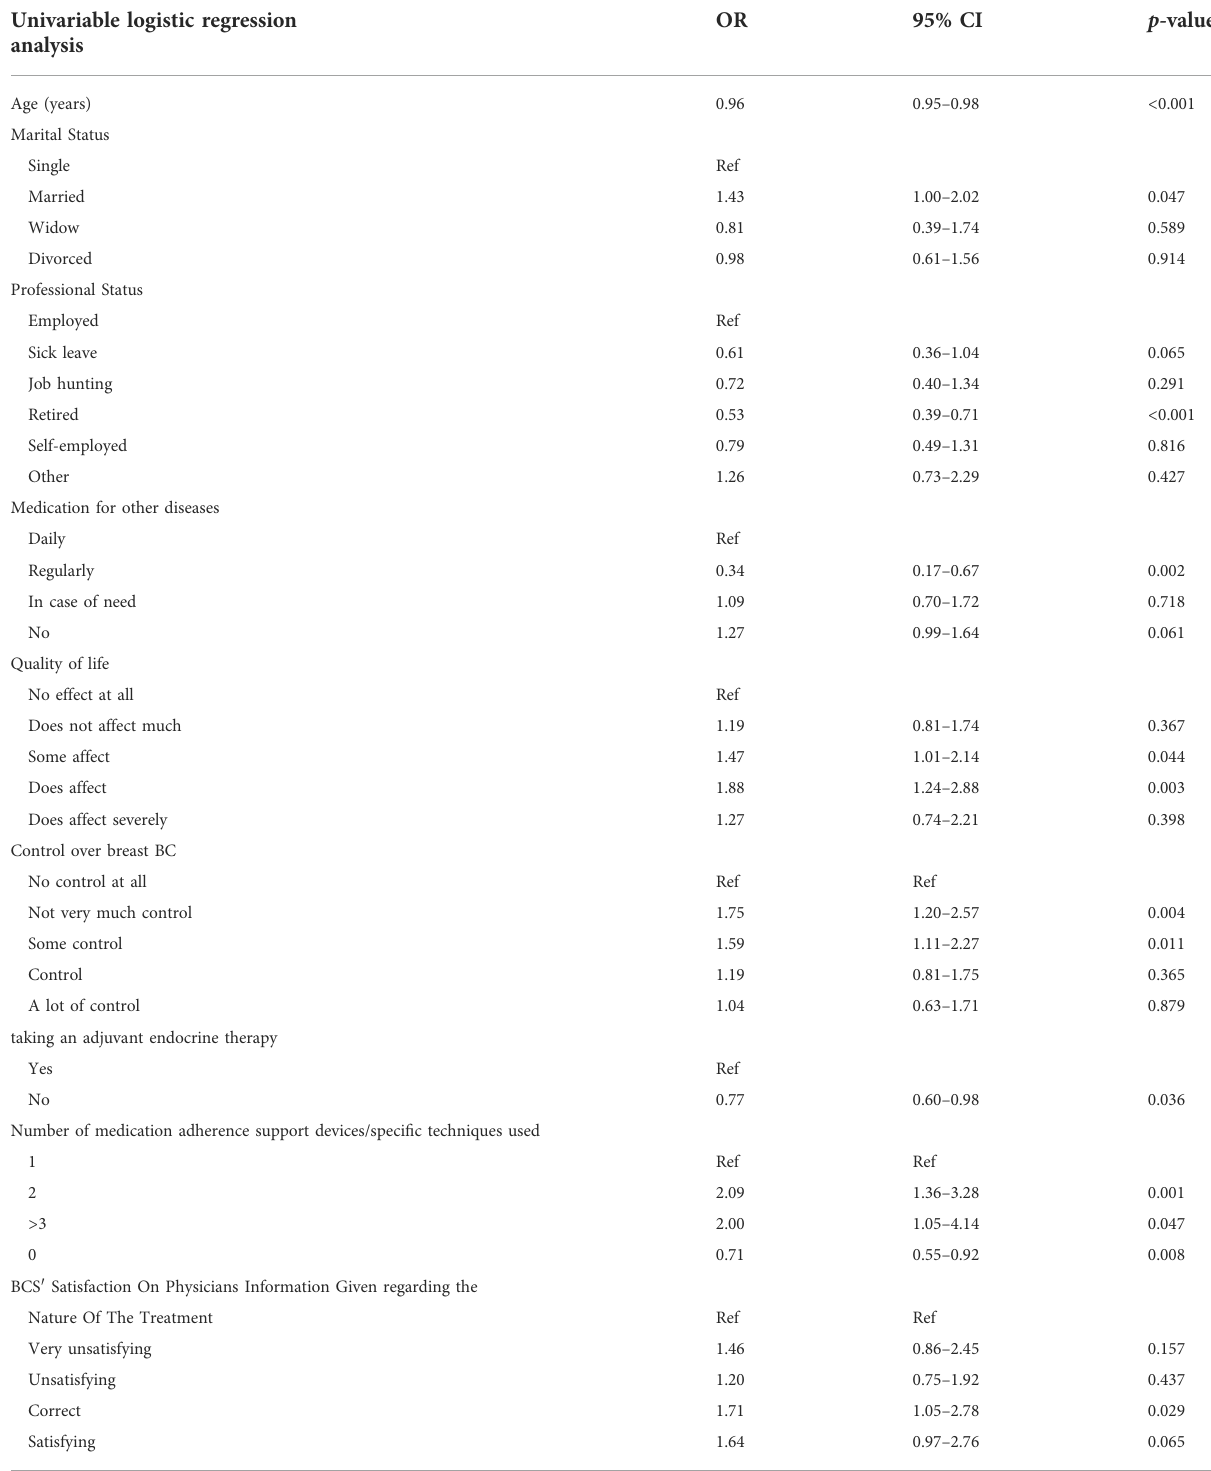
TABLE 3 Factors associated with accepting an eHealth tool to manage OHT in BCS (Seintinelles study,